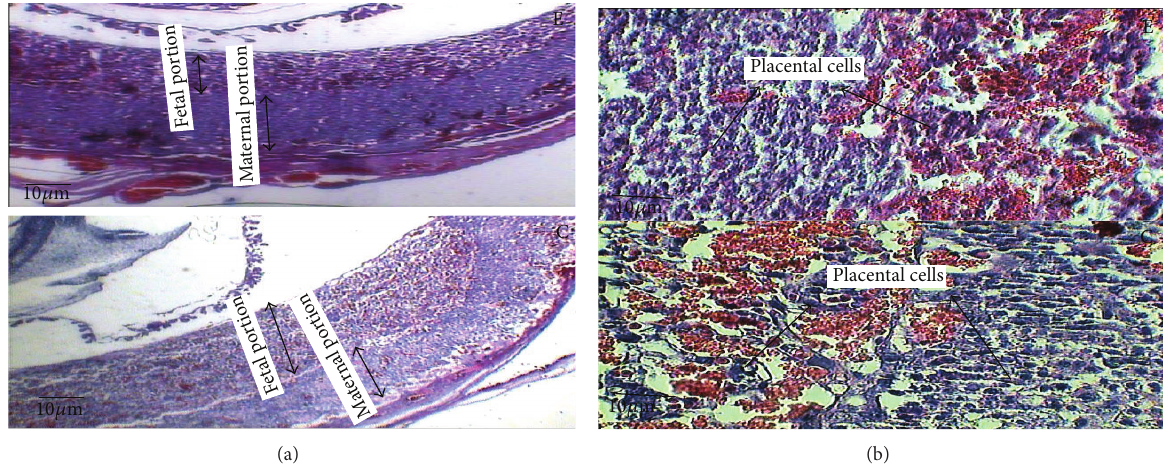
Figure 7: The microscopic image of the time-dependent effect of oral morphine consumption in the experimental (E) groups and the control (C) groups in the 14-day-old placenta with 40x magnification, (a) illustrating the thicknesses of both maternal and fetal portions of the placenta by the double-headed arrow. (b) The microscopic image of the experimental group and the control group in the 14-day-old placenta with 40x magnification, illustrating the placental